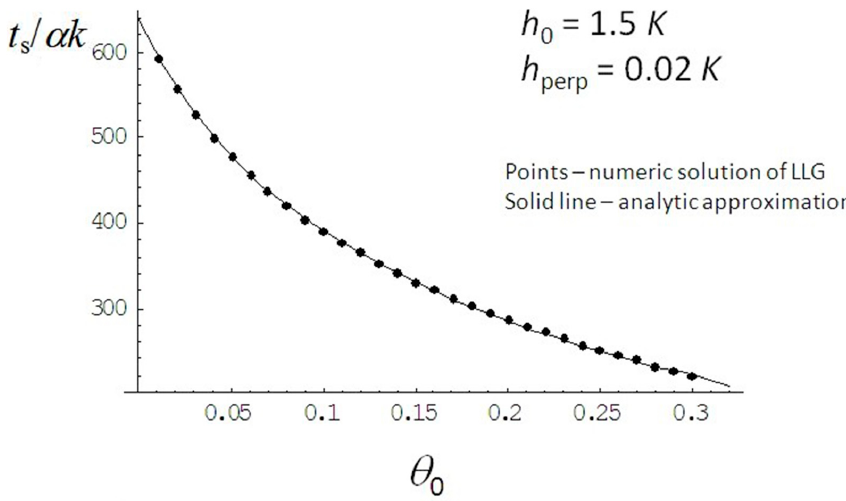
Figure 8. The magnetic switching time t s calculated using a numerical approach (points) and an analytical method (solid line) is shown as a function of the initial angle θ 0 in the context of the switching field ( h 0 = 1.5 × K ) supplied along the − z axis, in addition to the bias field ( h perp = 0.02 × K ) given in the ( π /2, 0) direction.